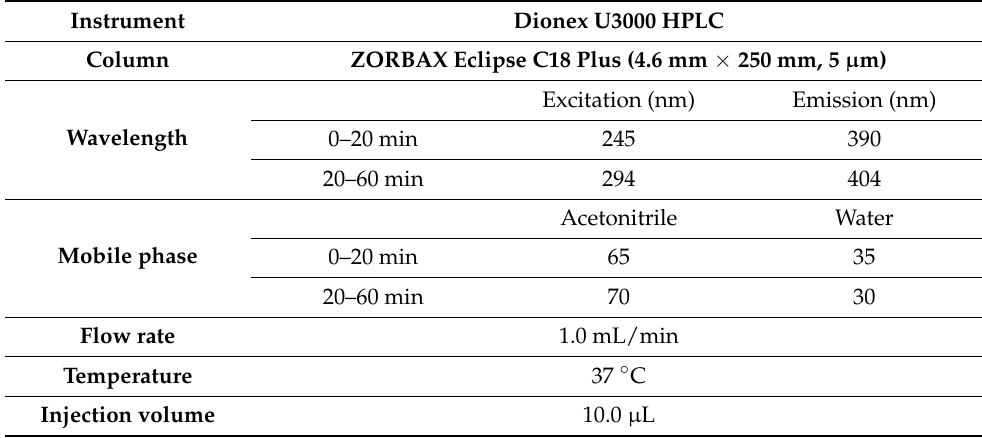
Table 1. HPLC-FLD analysis conditions for the polycyclic aromatic